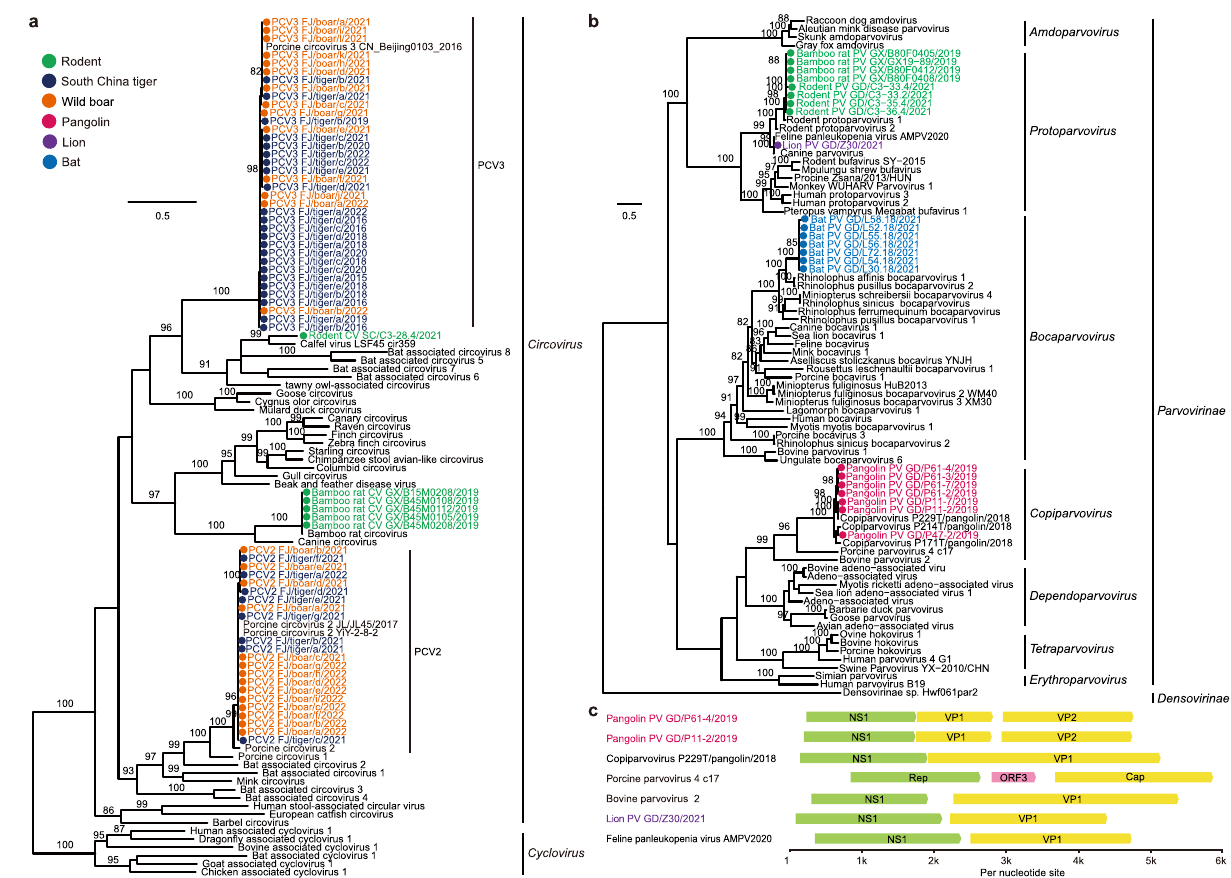
Fig. 6 | Maximum likelihood trees of the circoviruses and parvoviruses based on the amino acid sequences of the NS1 gene. a Circoviruses, rooted with the cycloviruses. b Parvoviruses, rooted with the Densovirinae sp. Both phylogenetic trees were estimated with the best- fi t substitutional model obtained by IQ-TREE